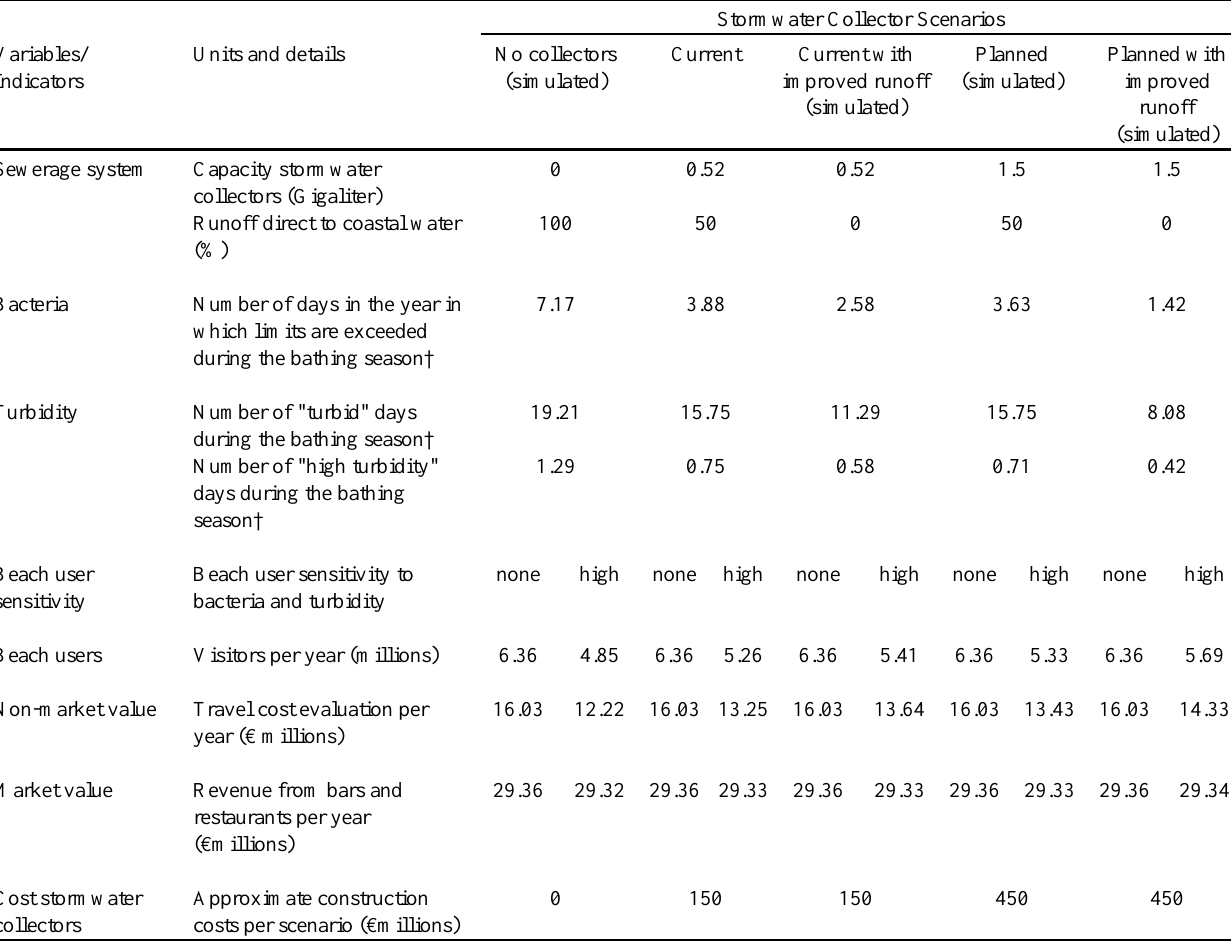
Table 2 . Stormwater collector scenarios. Scenario analysis is related to changes in operation of the stormwater collectors. The model operator (stakeholder) has the option of selecting two variables related to the sewerage system (capacity and direct runoff), as well as the sensitivity of beach users to changes in water quality (turbidity and runoff). Because this sensitivity is currently unknown, only the two extremes are shown in the table: none and high (both to bacteria and turbidity). The two extremes demonstrate the maximum possible difference to both the non-market and market value of the beaches for each scenario. The approximate cost of constructing the stormwater collectors for each scenario is included for comparison. It should also be noted that the number of turbid days is the same for both the “current” and “planned” scenarios because although increasing